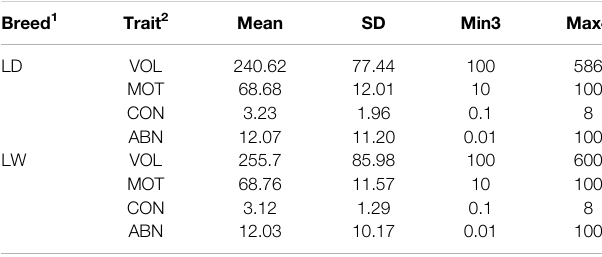
TABLE 2 | Description statistics for semen traits in two breeds.